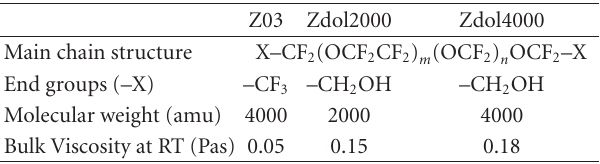
Table 1: Lubricants used in the